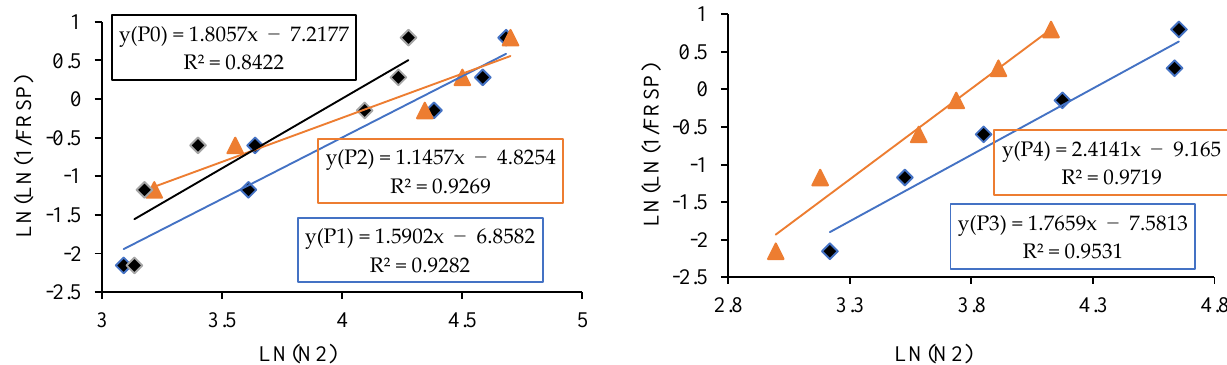
Figure 17. Weibull distribution for P0, P1, P2, P3 and P4 mixes at failure on 28 days. Figure 21. Weibull distribution for P0, P1, P2, P3 and P4 mixes at ultimate on 7 days. Figure 20. Weibull distribution for P0, P1, P2, P3 and P4 mixes at ultimate on 7 days. Table 6. Weibull distribution parameters and regression coefficients.